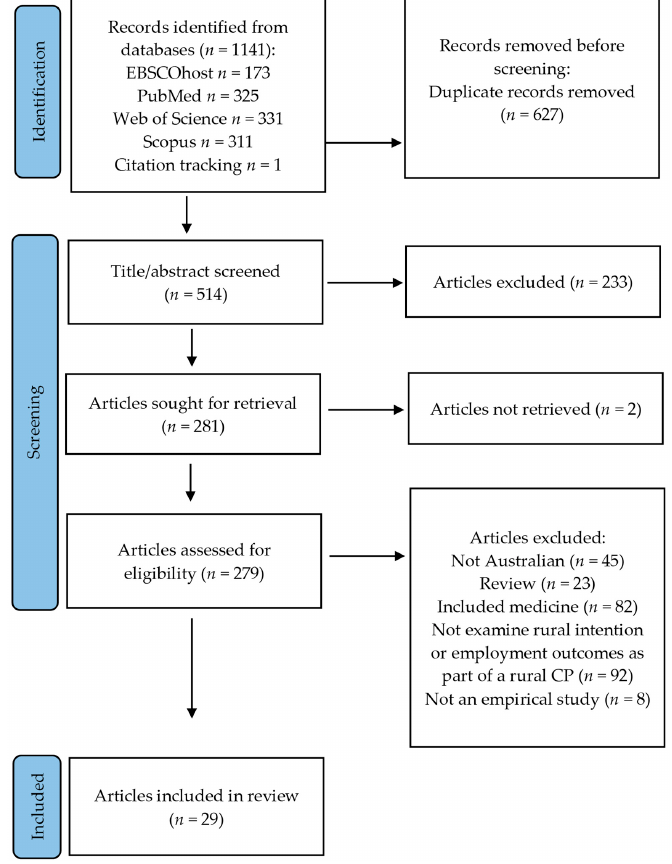
Figure 1. PRISMA flow chart of included articles, based on Page et al., 2021 [15].